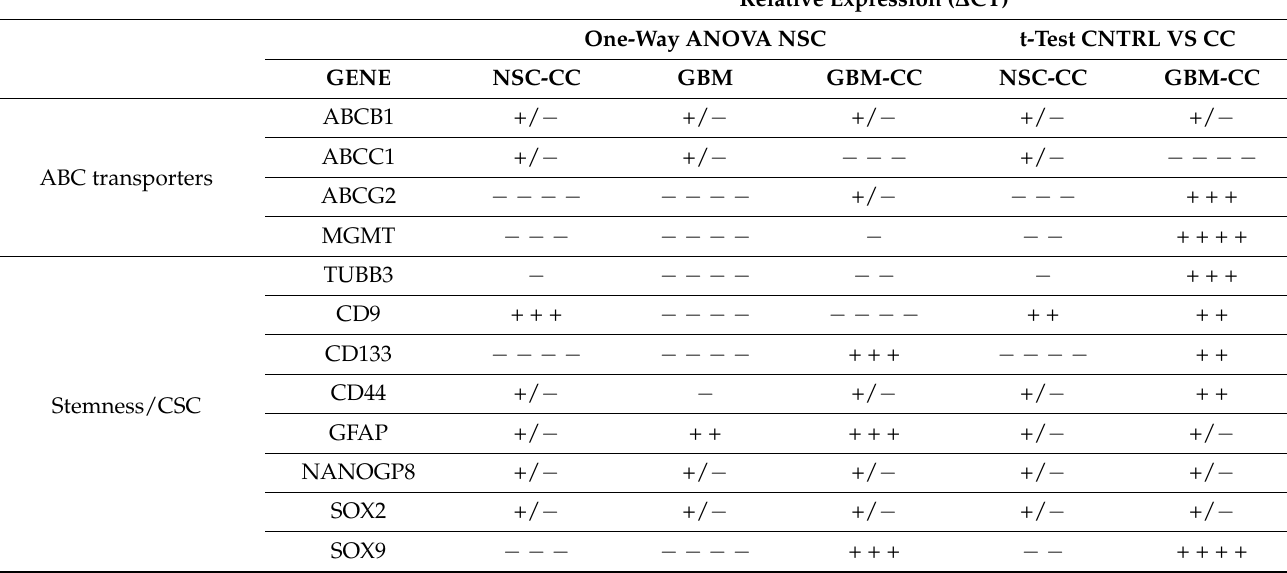
Table 1. Relative expressions of gene transcripts detected using qPCR. Delta Ct = [Ct Gene of interest minus Ct ACTB]. One-Way ANOVA was performed to determine the tendency of the variance; based on those results, the corresponding t-test was performed comparing the cell line versus the same cell line with cocultured (CC)